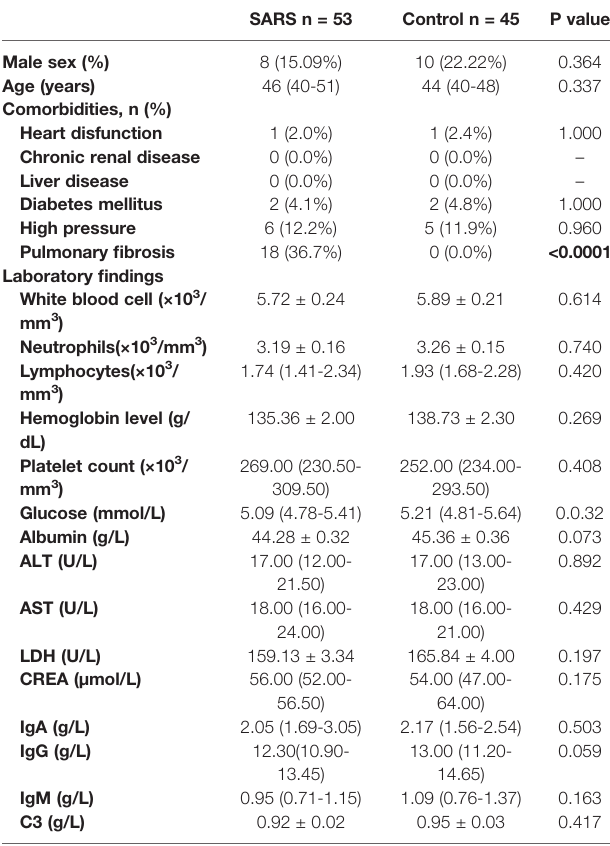
TABLE 1 | Clinical characteristics and laboratory fi ndings of the SARS and Control groups in